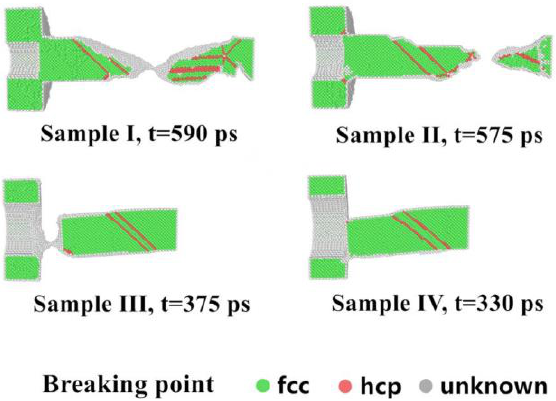
Figure 3. Snapshot of welded structures when rupture occurred for Samples I, II, III and IV (fcc, face-centered-cubic and, hcp, hexagonal-close-packed).